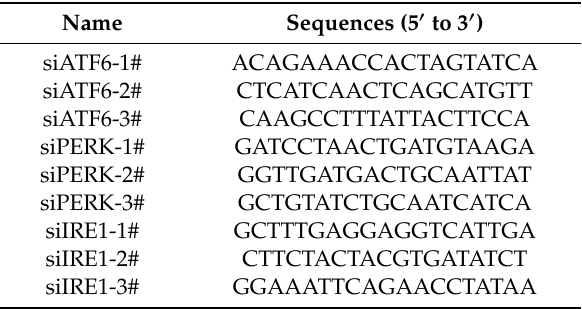
Table 1. Small interfering RNA (siRNA)